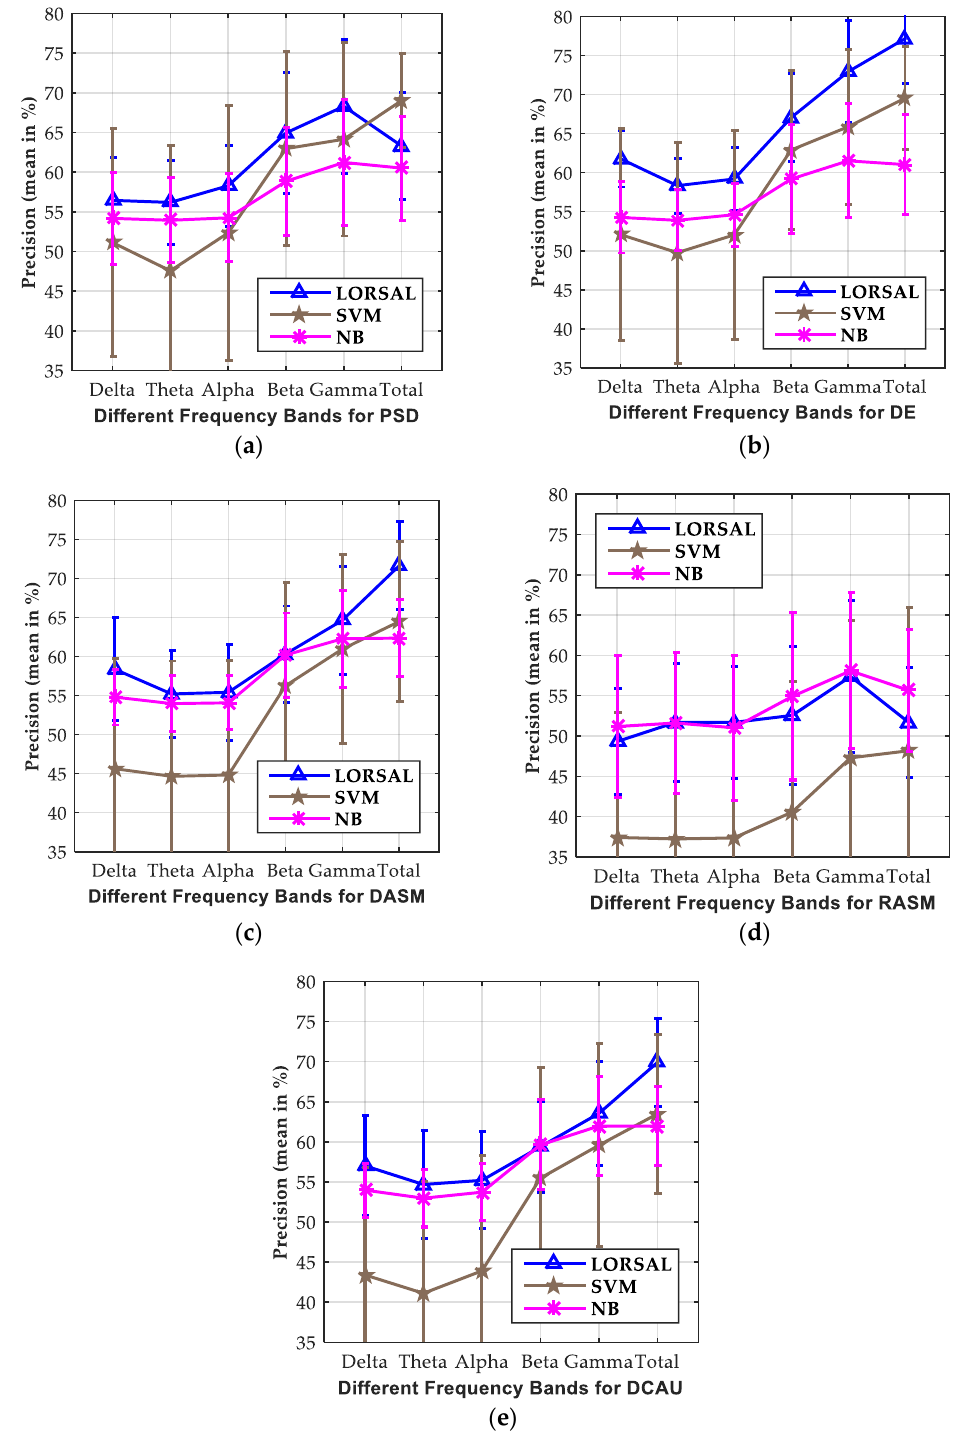
Figure 4. Effects of the different frequency bands (Delta, Theta, Alpha, Beta, Gamma, and Total) on Figure 4. E ff ects of the di ff erent frequency bands (Delta, Theta, Alpha, Beta, Gamma, and Total) on the the classification precisions for LV/HV emotions obtained by the LORSAL, SVM, and NB classifiers classification precisions for LV / HV emotions obtained by the LORSAL, SVM, and NB classifiers for the for the five different features: ( a ) PSD, ( b ) DE, ( c ) DASM, ( d ) RASM, ( e ) DCAU. five di ff erent features: ( a ) PSD, ( b ) DE, ( c ) DASM, ( d ) RASM, ( e )